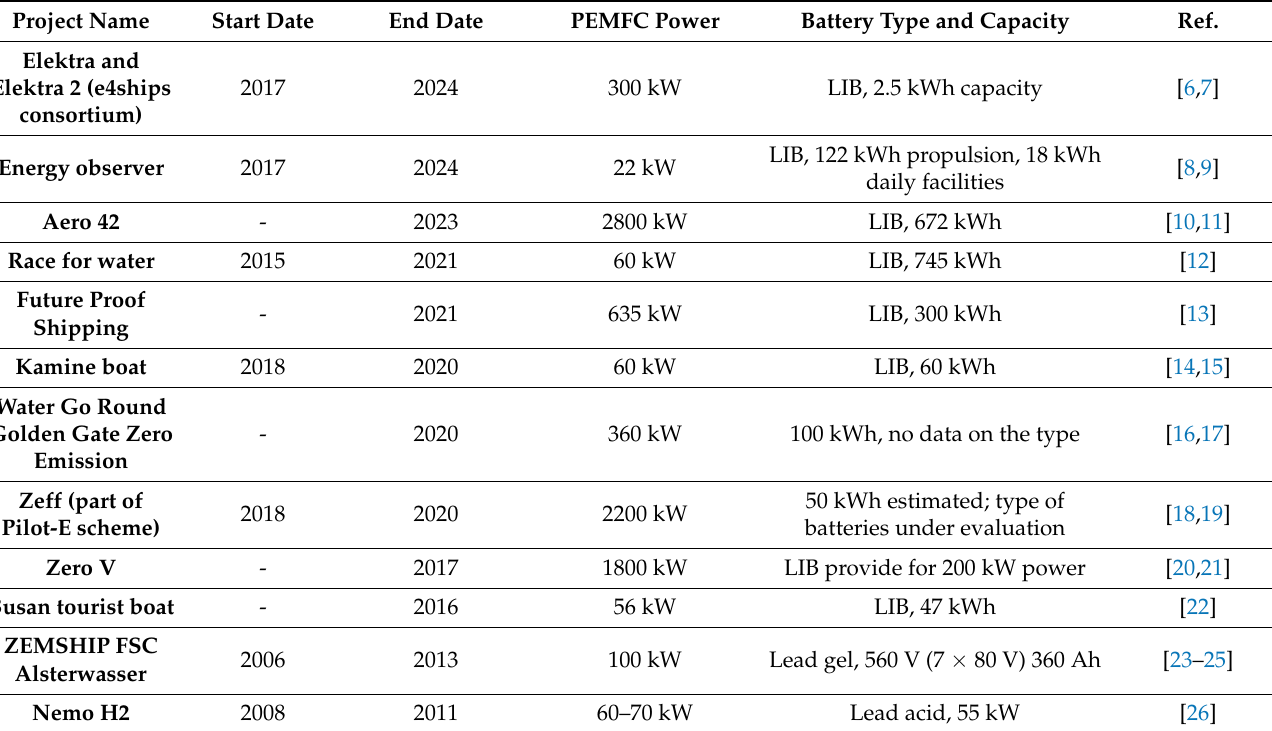
Table 1. List of projects on hybrid PEMFC/BESS propulsion systems. Elaborated from